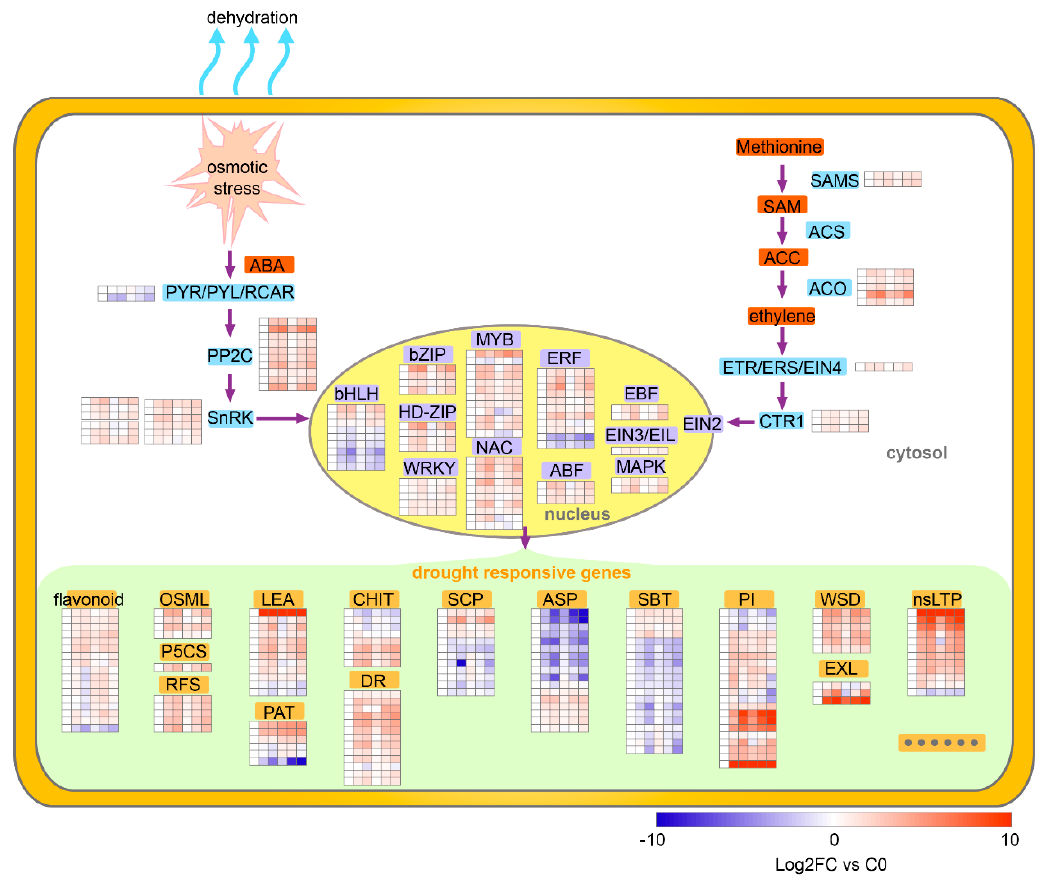
Figure 8. The schematic representation of the main process of drought response in potato.